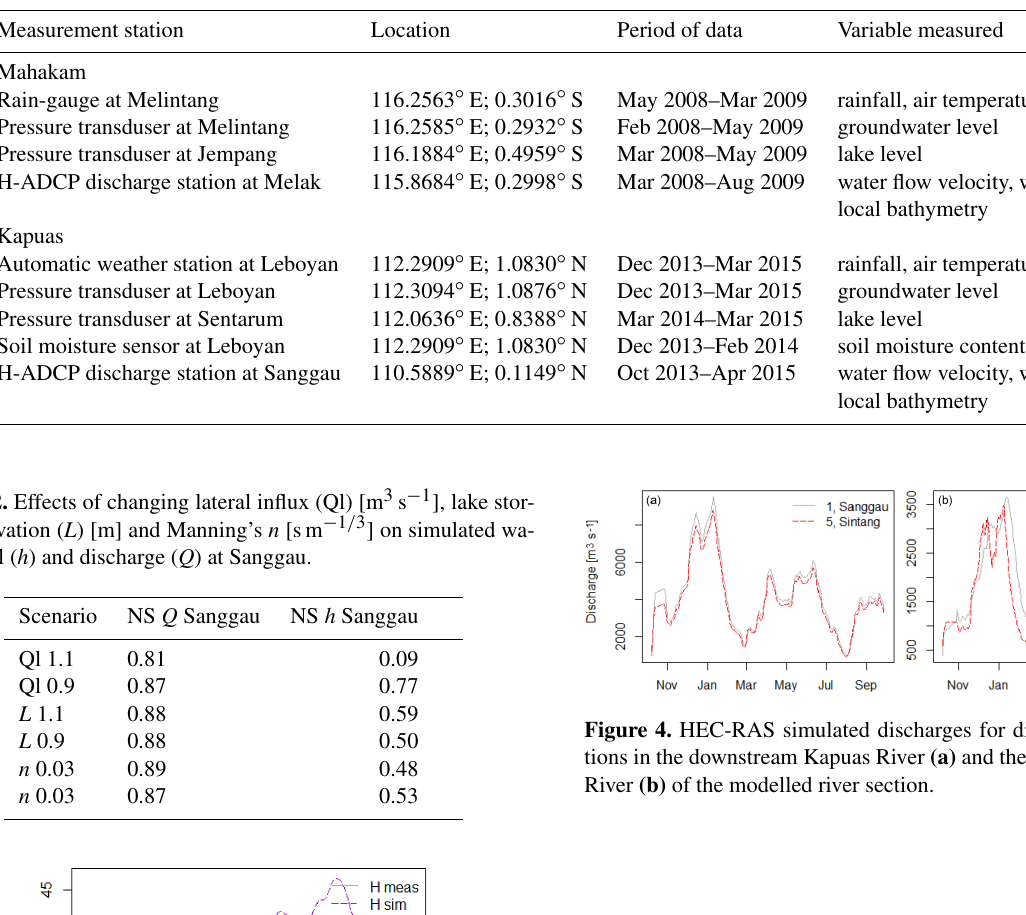
Table 1. Description of collected field data.